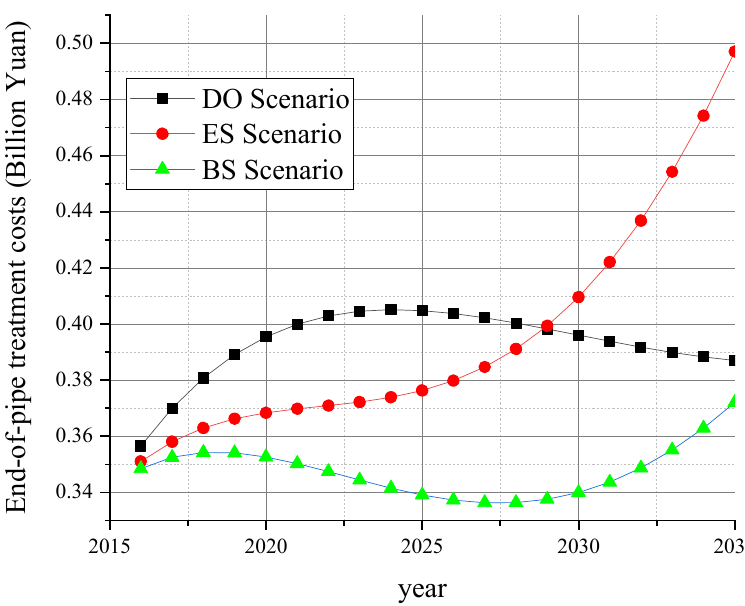
Figure 5. End-of-pipe costs of the DO ES and BS scenarios.